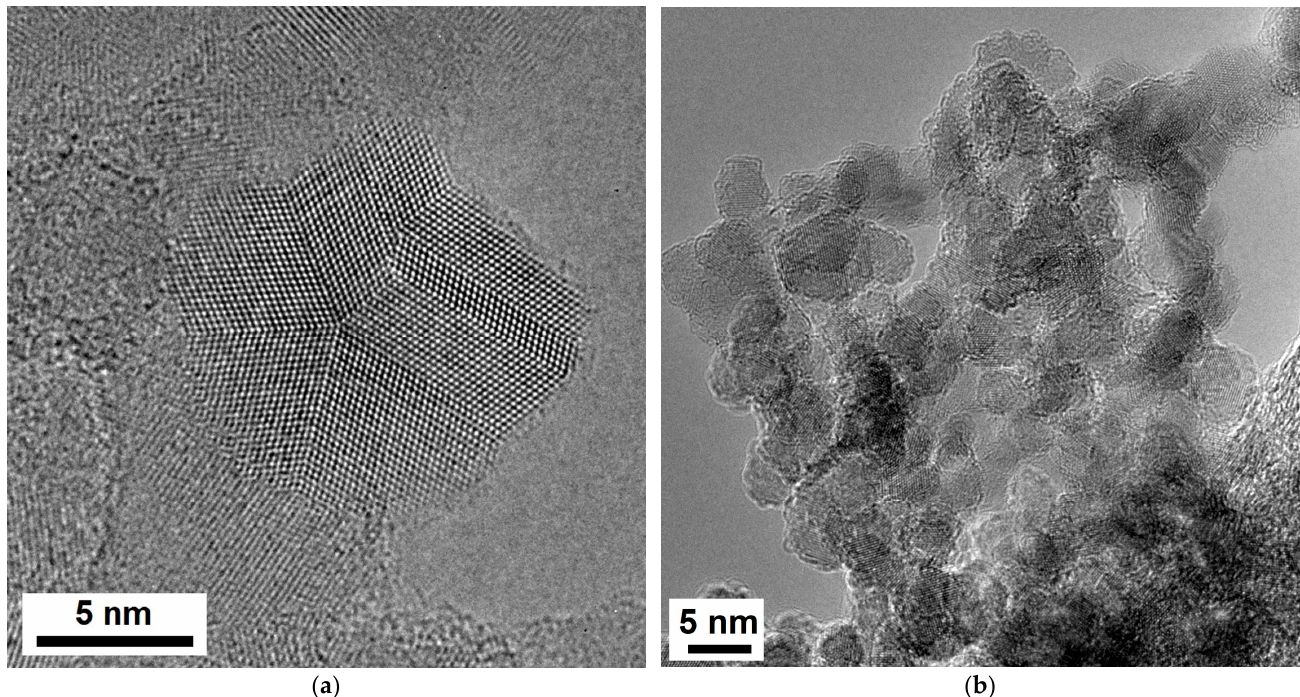
Figure 1. TEM images of nanodiamonds: ( a ) prime nanoparticle with twins; ( b ) agglomeration of nanodiamonds.